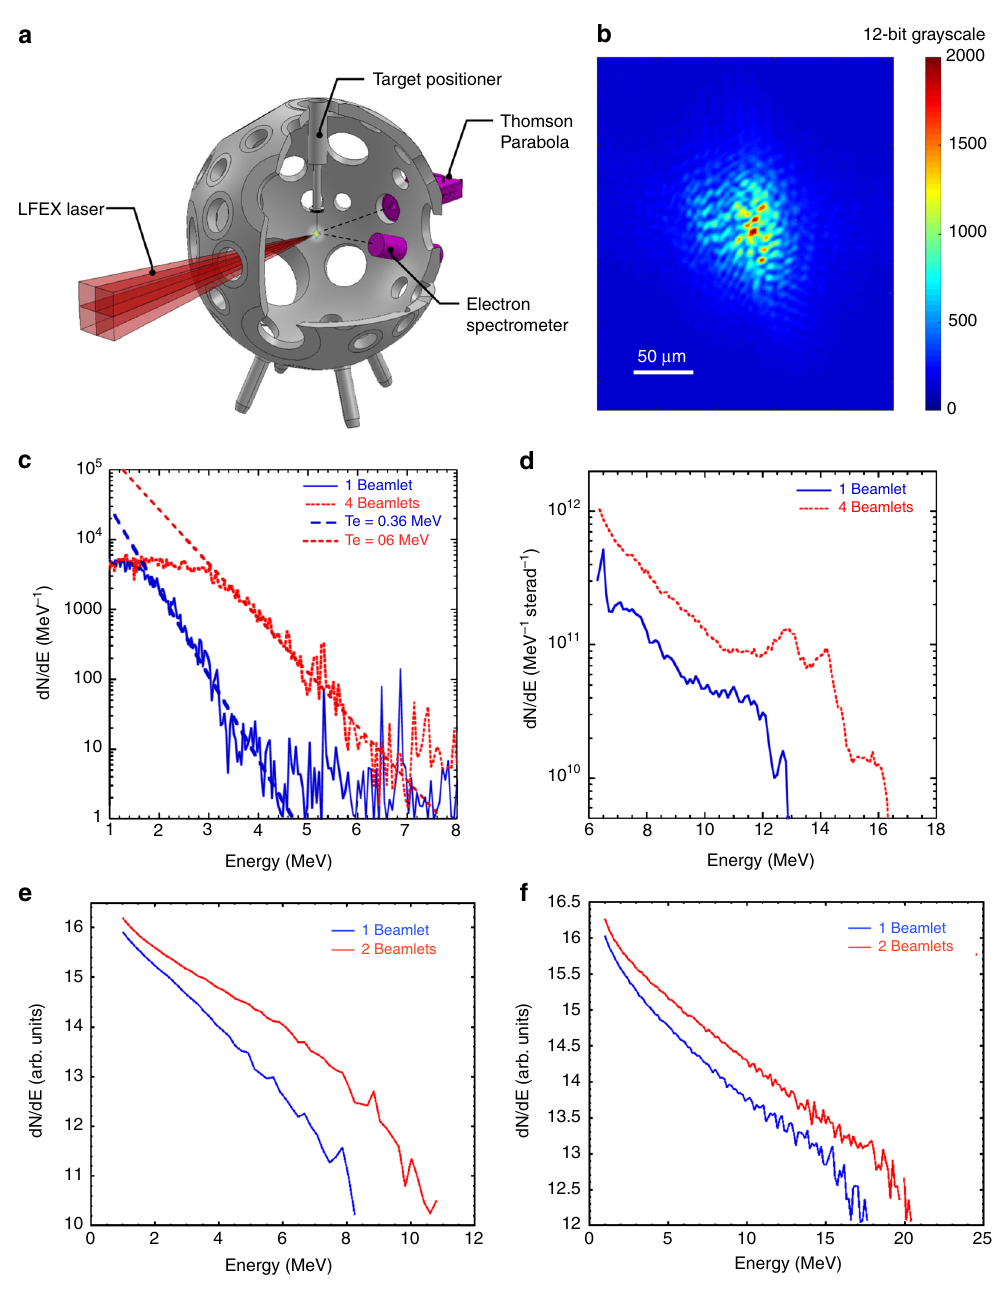
Fig. 1 Experimental setup and results. a Schematic of the experimental setup. The energy as well as the nominal intensity on target are kept constant and correspond respectively to 270 J and 2.5 × 10 18 W/cm 2 . Fast electron and proton beam data are collected by electron spectrometer and Thomson parabola. b Far fi eld image of the LFEX focal spot using the ~ 1mJ OPCPA pulse showing the 4-beamlet interference pattern. c , d Experimental results for fast electron spectra and proton spectra, respectively. The red dashed line represents the four-beamlet interaction data and the blue solid line the single beamlet interaction data. It appears clear the enhancement of fast electron and proton beam generation for interfering beamlets. 2D PIC simulation results for e fast electron and f proton beam generation for laser con fi guration close to the experimental one. The red line represents the 2-beamlet irradiation result and the blue line the single beamlet